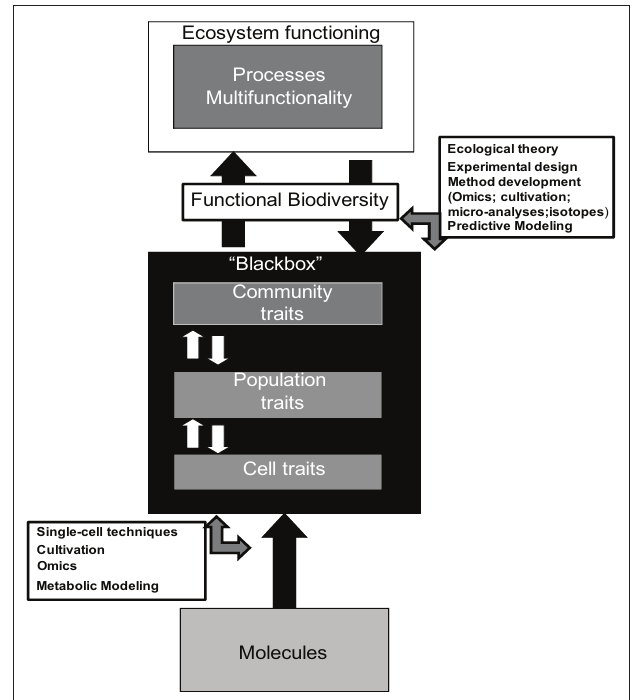
FigurE 1 | Schematic representation of important elements in elucidating the role of microbial diversity in ecosystem functioning. Crucial element is the application of a Functional Biodiversity concept to link microbial diversity to ecosystem functioning. This approach will facilitate predictive ecosystem modeling and will be fostered by omics techniques. However, to make this conceptual step the mechanistic insight into what is going on in the “black box” being the structure and functioning of microbial communities and underlying populations an cells, needs to be elucidated. Application of ecological theory, conceptual experimental design, novel methodology, and mathematical modeling will be the key to gain access to